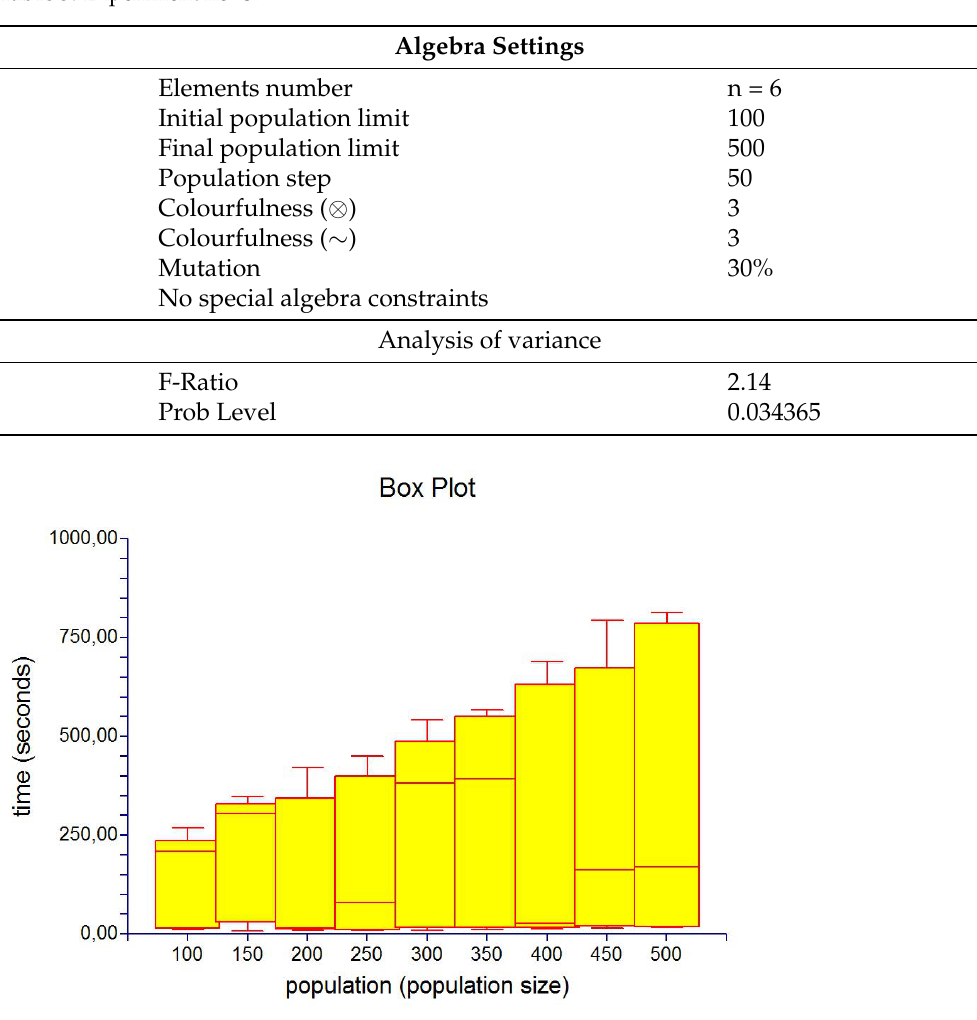
Table 3. Experiment no. 3.